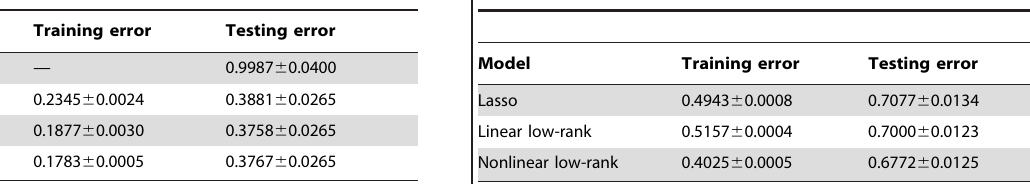
Table 3. Root-mean-squared error (RMSE) comparison among different models on the connectivity map gene expression